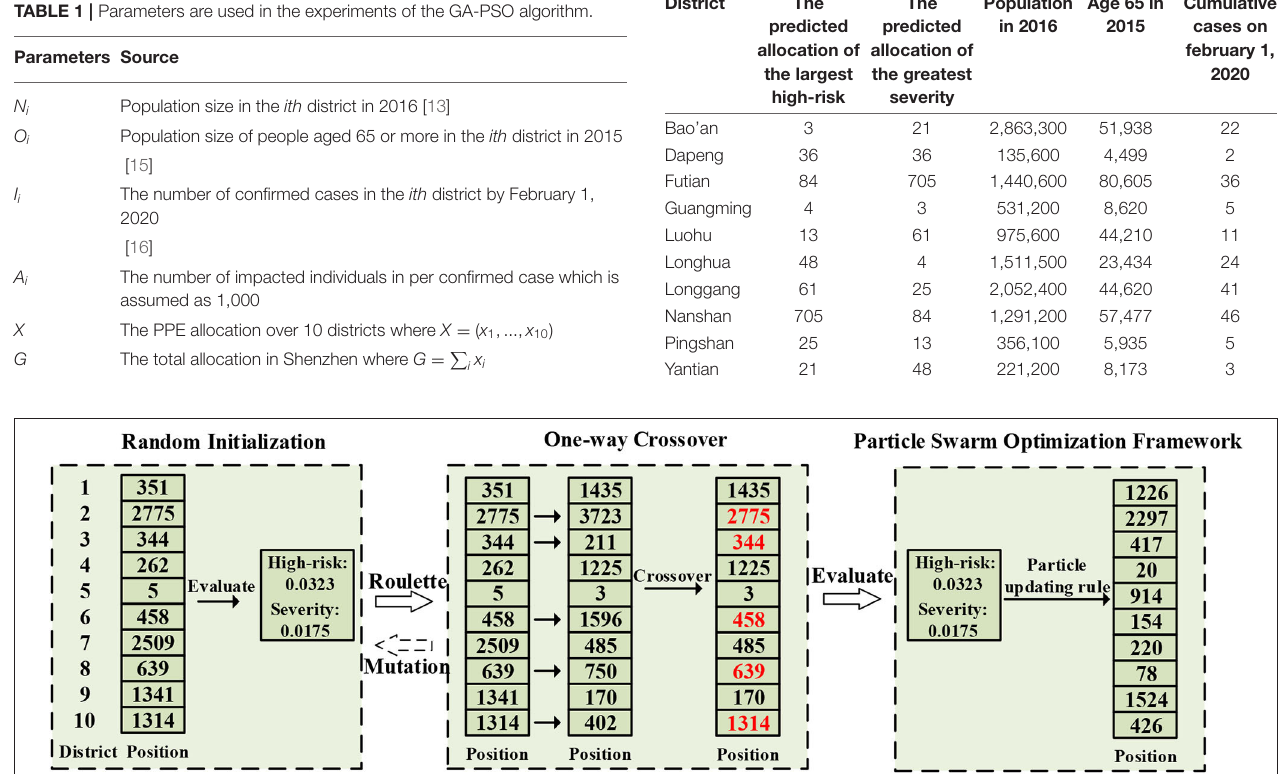
FIGURE 1 | The overview of the GA-PSO algorithm, which comprises three components, i.e., the random initialization, the genetic operations, and the particle swarm optimization framework. The initial particles are selected by the roulette method. When a random number is less than the mutation rate, the particle is executed the initialization operation.